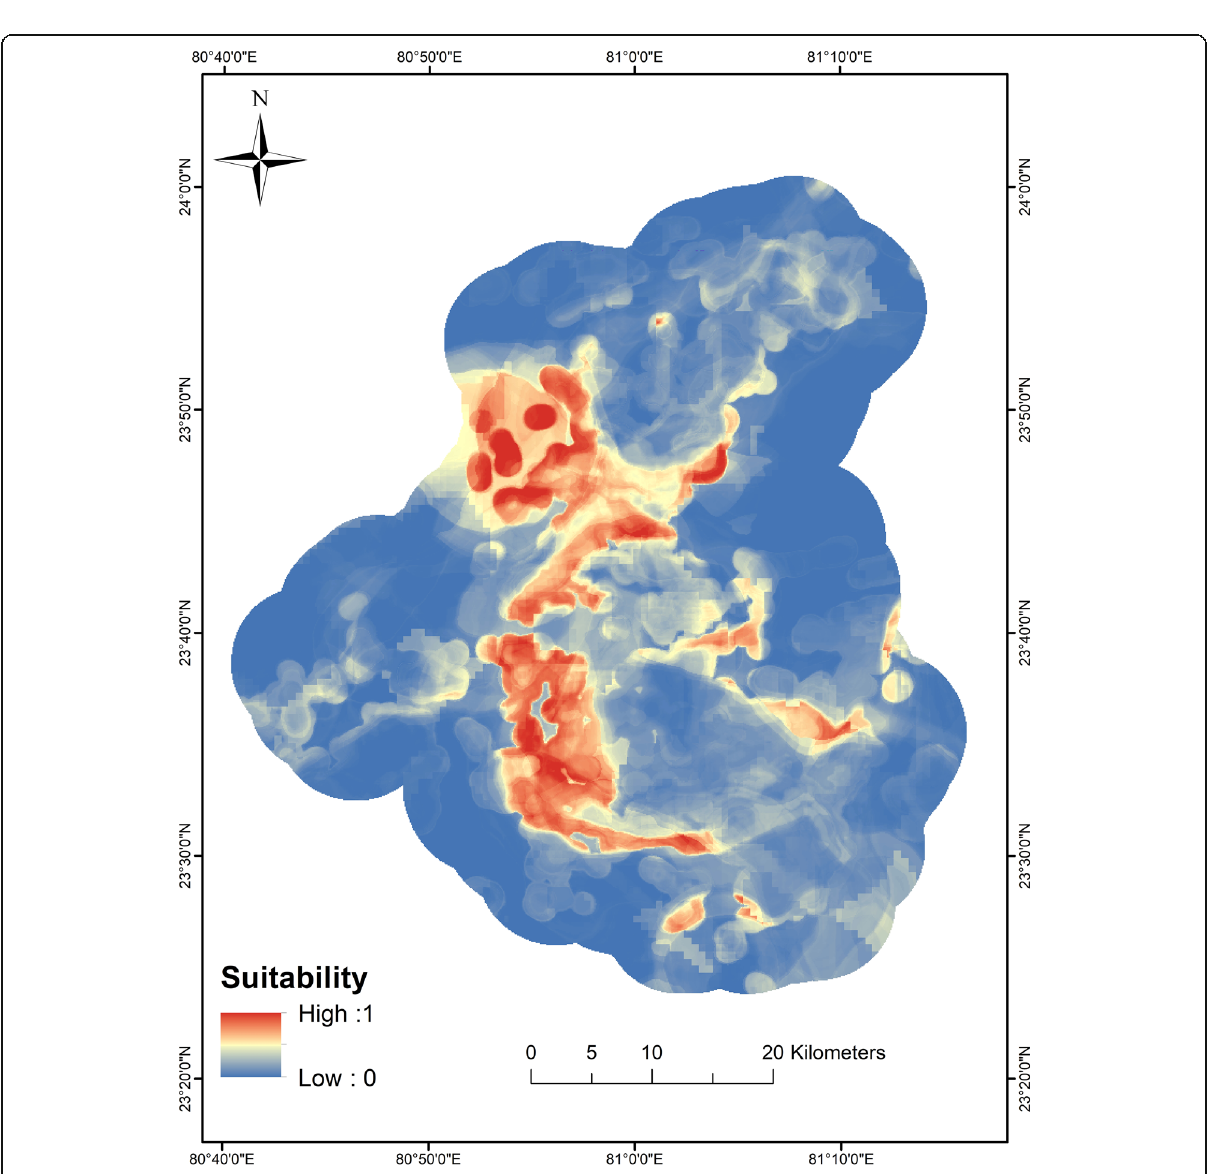
Fig. 4 Predicted habitat suitability of sloth bears in and around Bandhavgarh Tiger Reserve. Red color indicates high suitability, and blue color indicates low